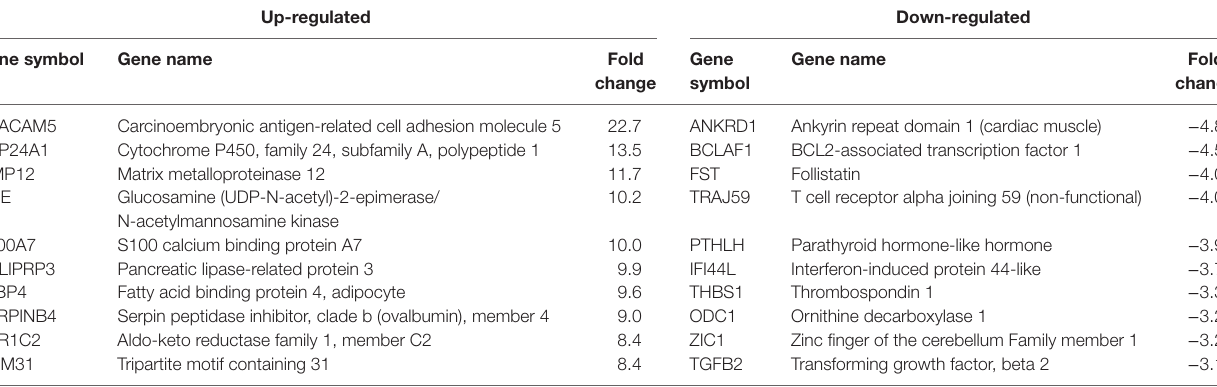
TaBle 2 | HPV18E6 top 10 up- and downregulated genes based on either the extent of up- or downregulation or on their known involvement in carcinogenesis.